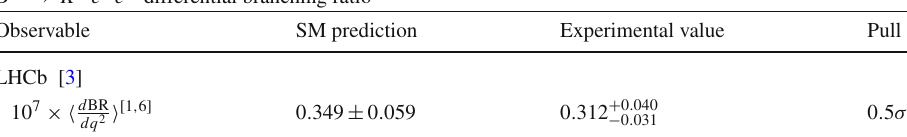
branching ratio of B + → K + e + e − included in the